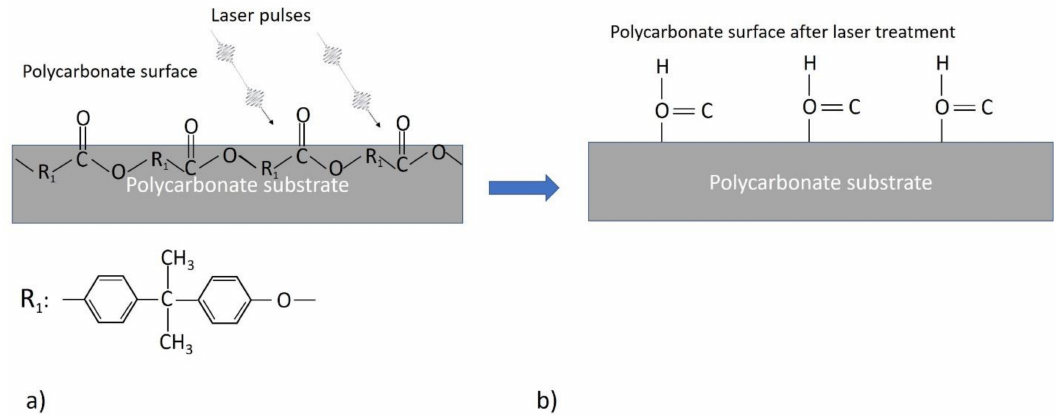
Figure 15. Schematic image showing the interaction of chemical groups on PC surface with laser pulses ( a ) and the broken bonds of carbonyl groups after laser treatment, leading to a formation of aldehyde groups on PC surface ( b